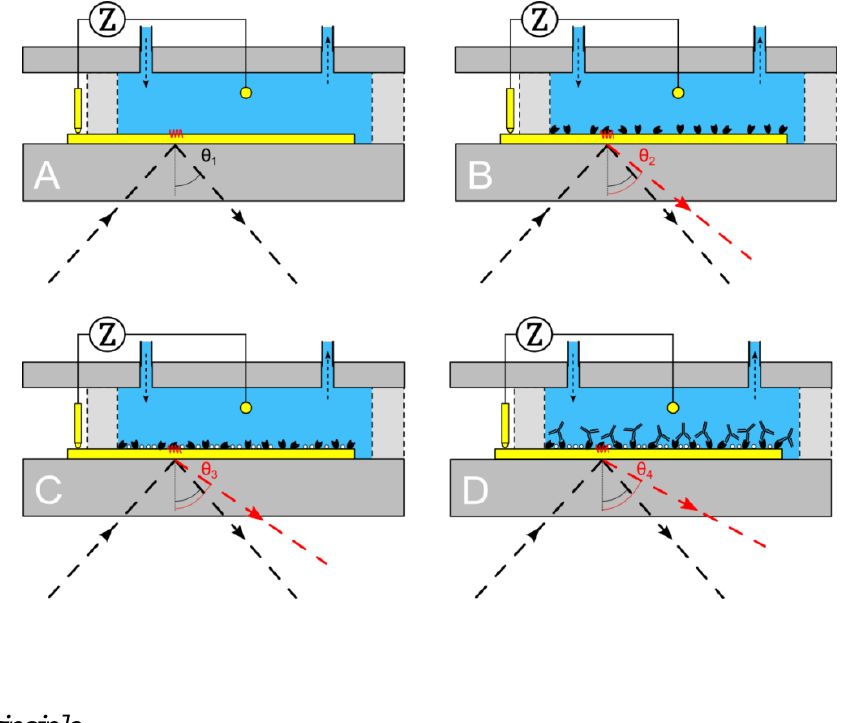
Figure 3. Different stages throughout the usability test. ( A ) Flow-cell is rinsed with 10 mM Tris-HCl solution, nothing is bound to the sensor surface. ( B ) Protein A is attached through physical adsorption to the gold surface, acting as a receptor for IgG1. ( C ) Non-occupied zones of the sensor surface are blocked with BSA molecules. ( D ) IgG1 is bound to the Protein